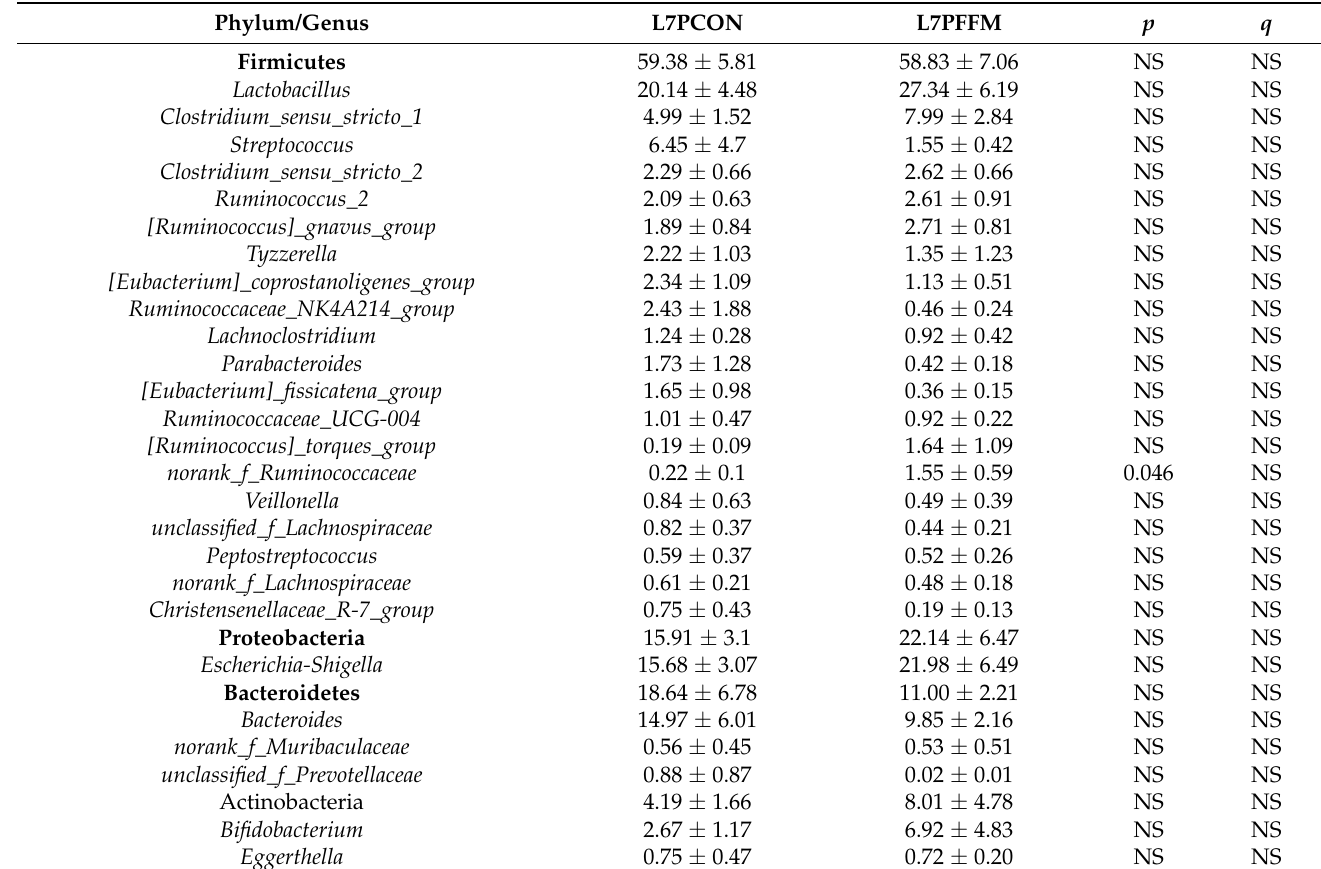
Table 6. Composition of the fecal microbiota of piglets on L7 at the phylum and genus